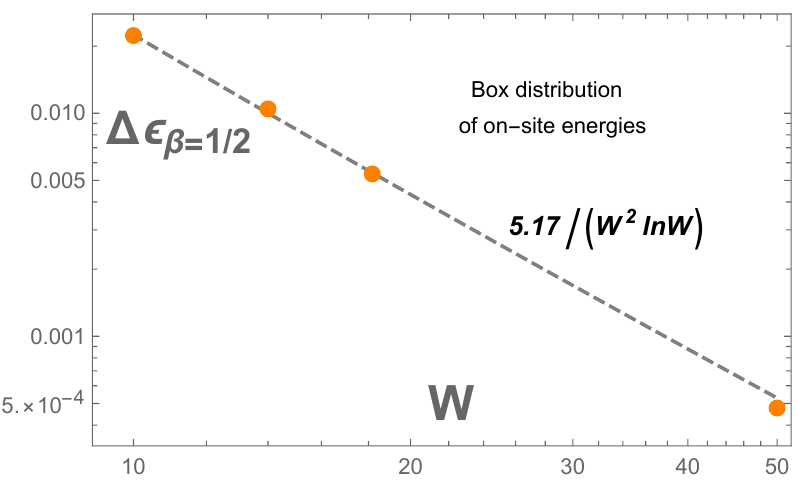
Figure 3: The accuracy of approximation for ε β , Eq. (70), for the box distribu- tion of on-site energies at large disorder W (cid:29) 1 . The difference ∆ ε β between the numerical solution for ε β = of the exact Eqs. (12), (14) and the approximate 1 / 2 solution for ε β = , Eq. (70), as a function of disorder strength W for a K = 2 Cayley 1 / 2 = 5.17 / ( W 2 ln W ) . tree. The dashed gray line is a fit to the function ∆ ε β = 1 / 2